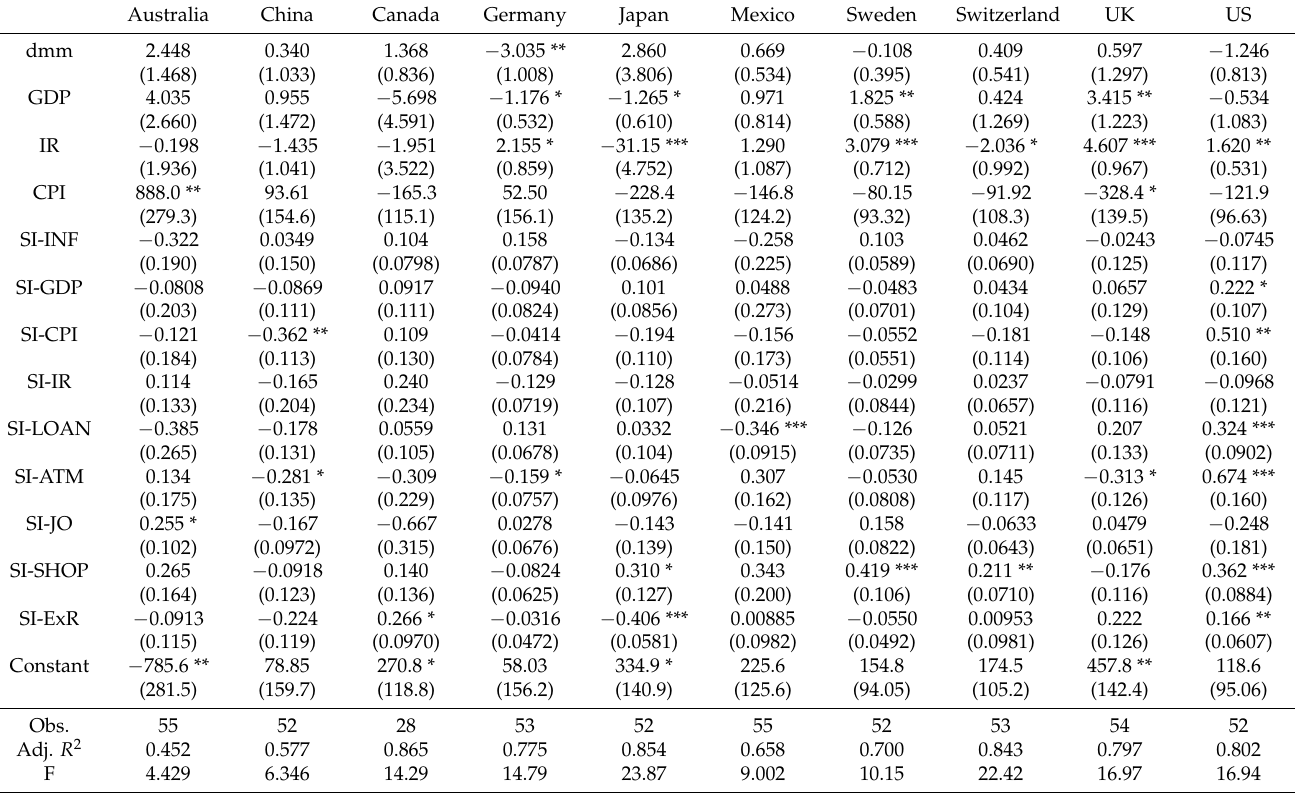
Table A20. Panel Regression OM Model with SI for Countries.